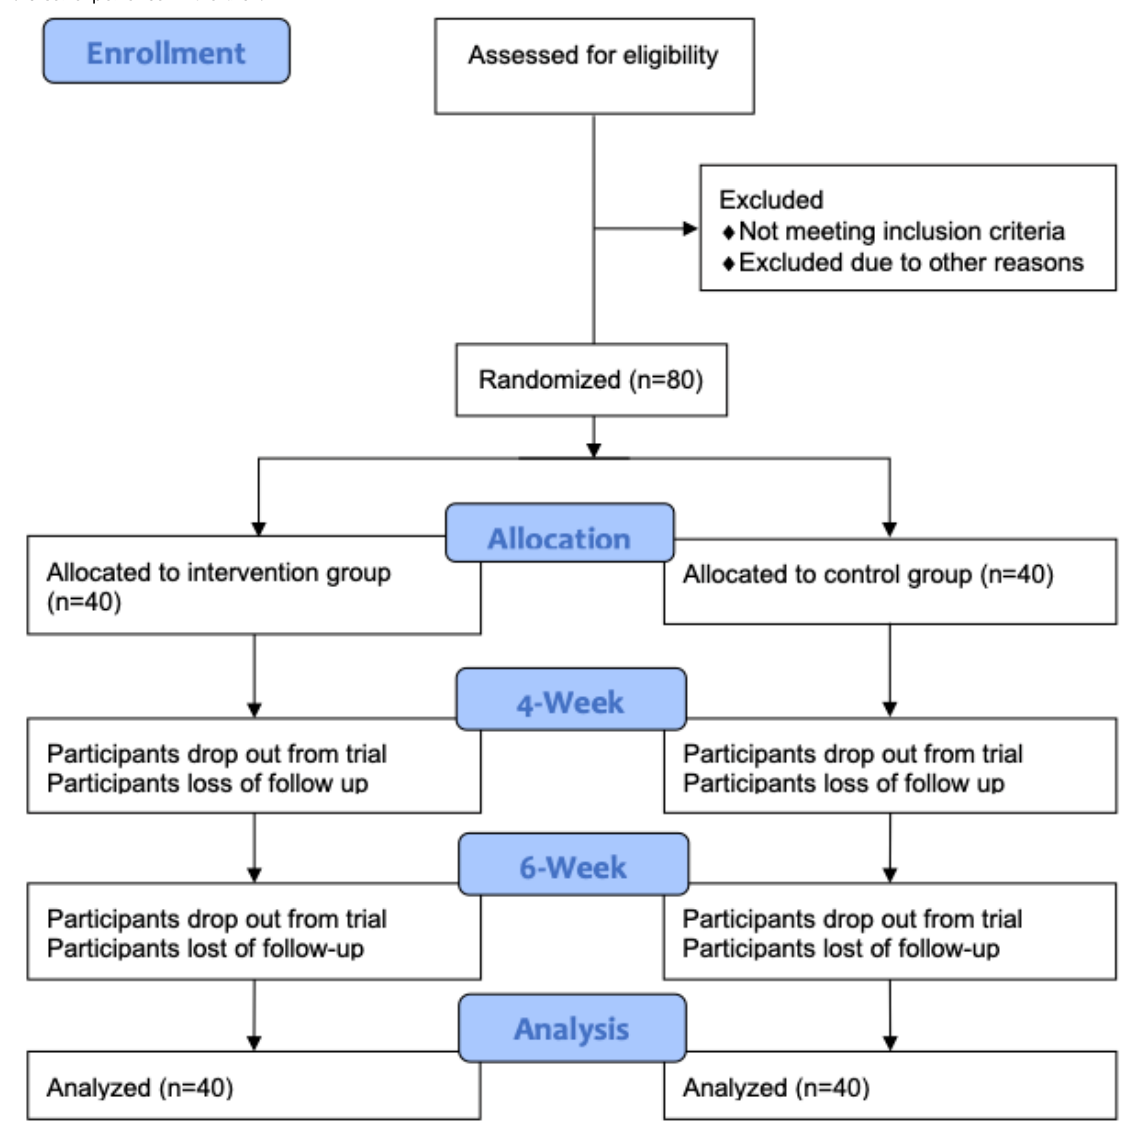
Figure 1. User experience in the